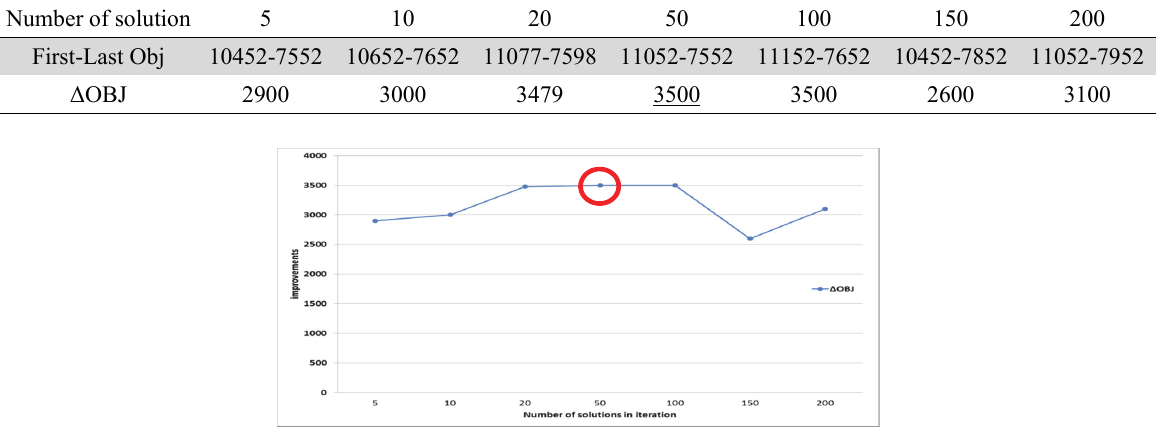
Fig. 8. The trend line of maximing improvements by considering different number of solutions in